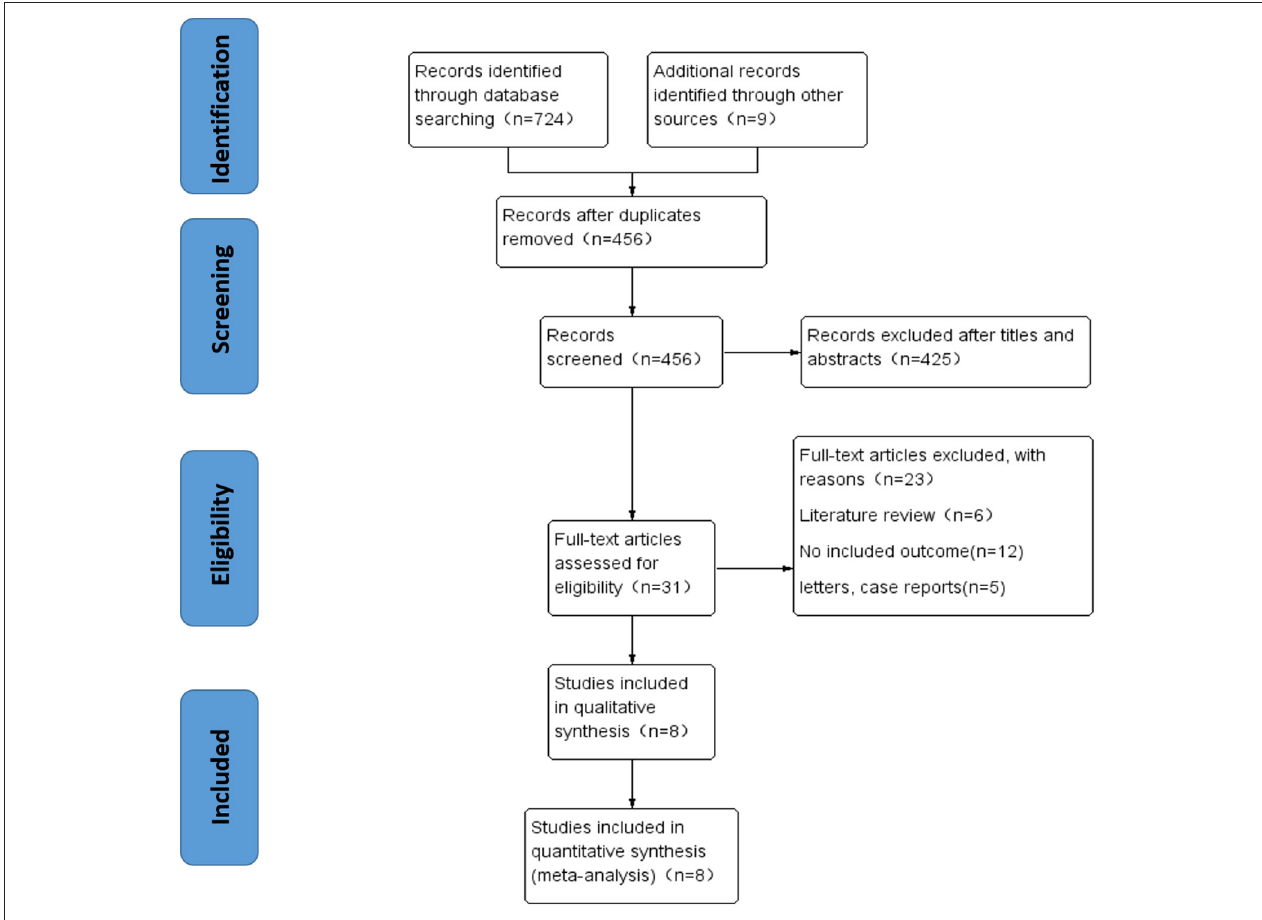
FIGURE 1 | Flowchart for the identification of eligible